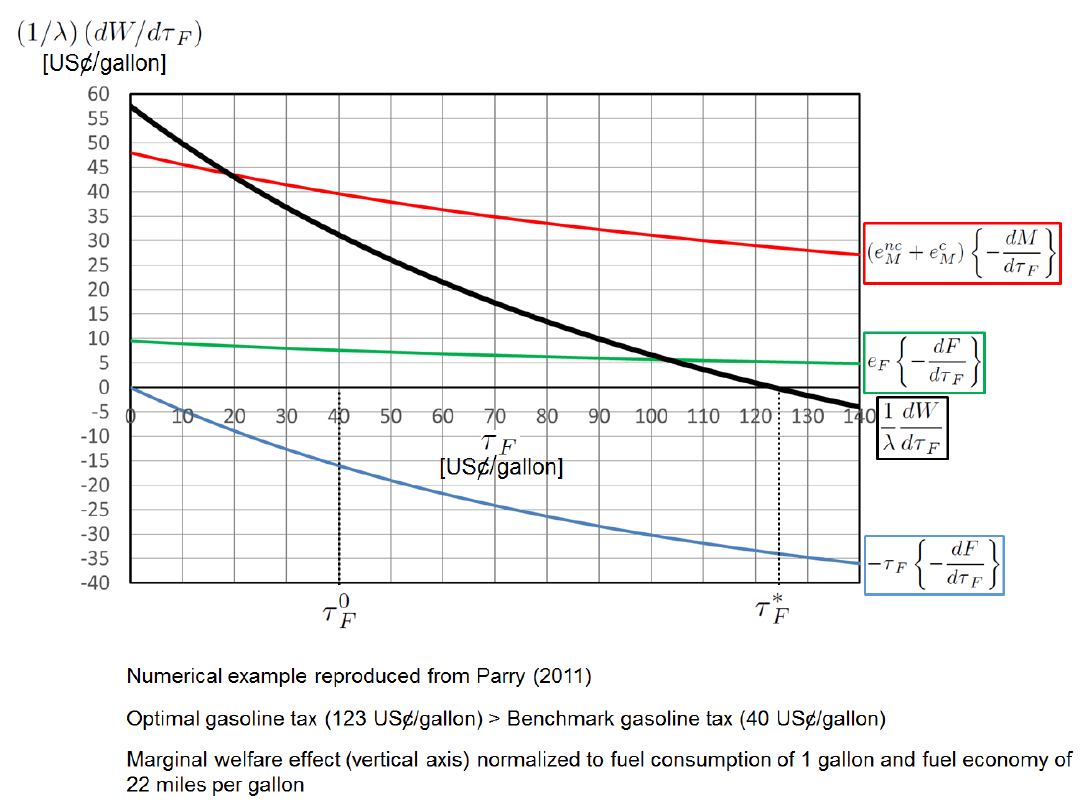
Figure 1. Example of the marginal welfare effect of the gasoline tax and optimal gasoline tax (reproduced from